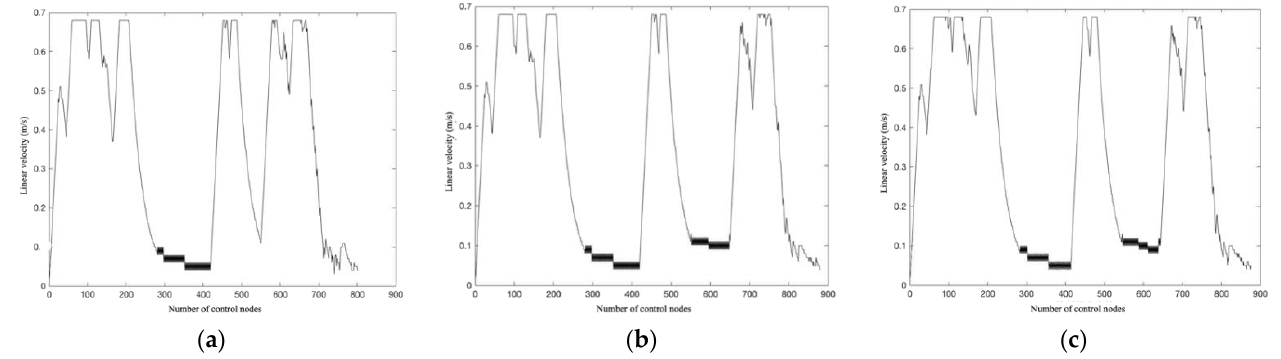
Figure 5. Simulation of robot attitude: ( a ) Path planning when adding one random obstacle; ( b ) Path planning when adding two random obstacles; ( c ) Path planning when adding three random obstacles.